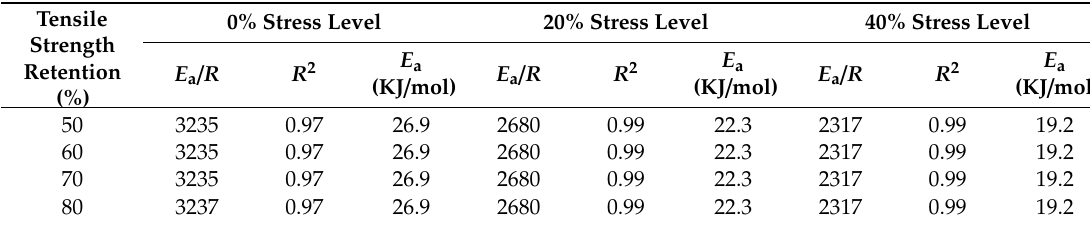
Table 7. Coe ffi cients of regression equations for Arrhenius plots.